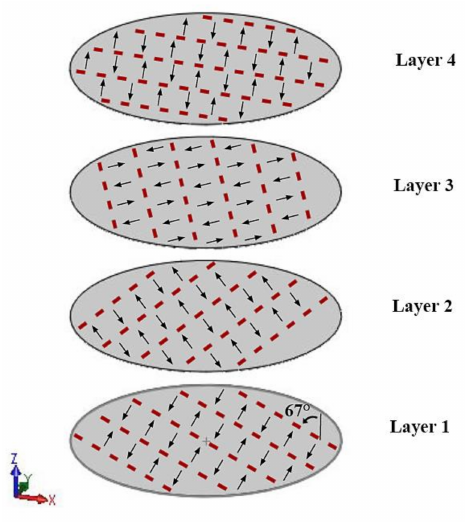
Figure 6. Stripes scan pattern (67 ◦ –hatch angle).